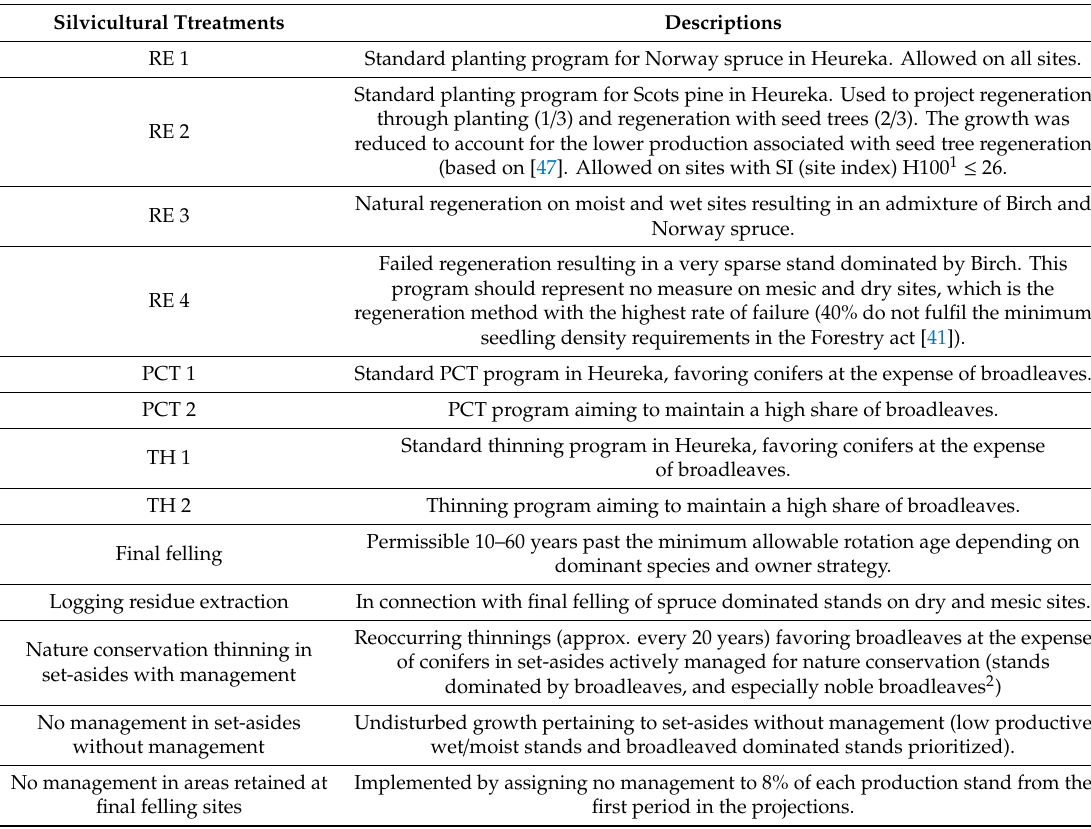
Table 2. Overview of the di ff erent silvicultural